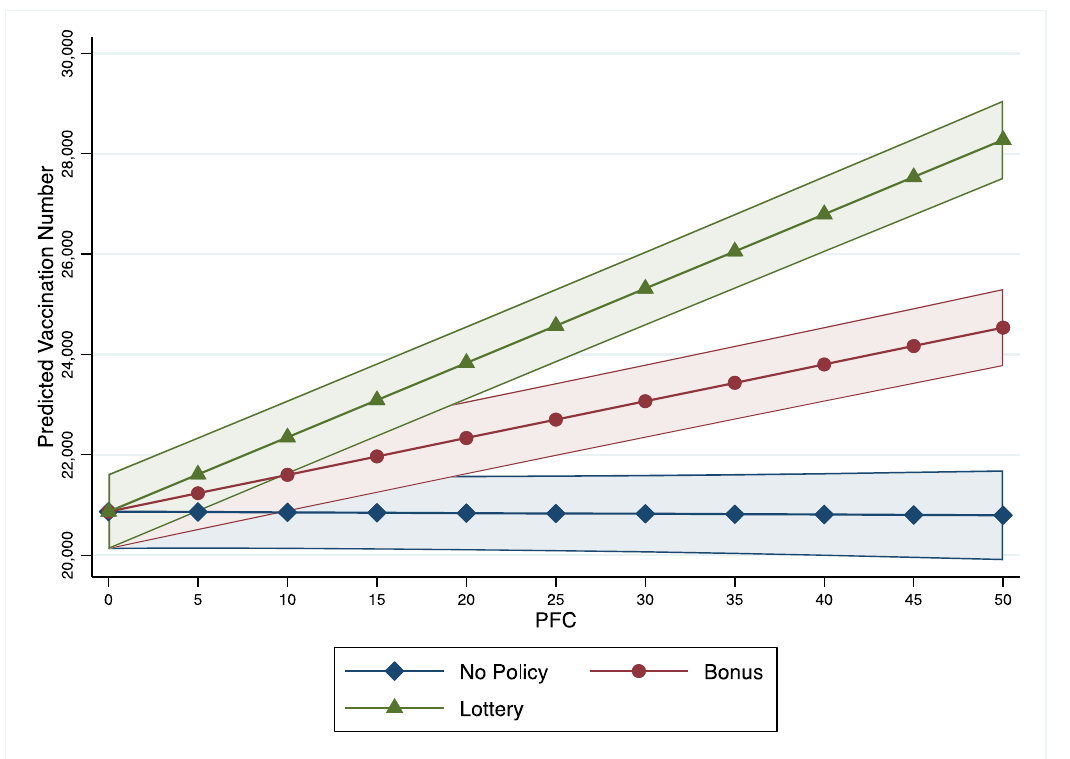
Figure 3. Interaction Effects between PFC and Vaccine Policies.